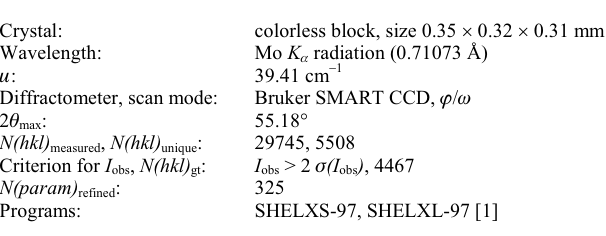
Table 1. Data collection and handling.